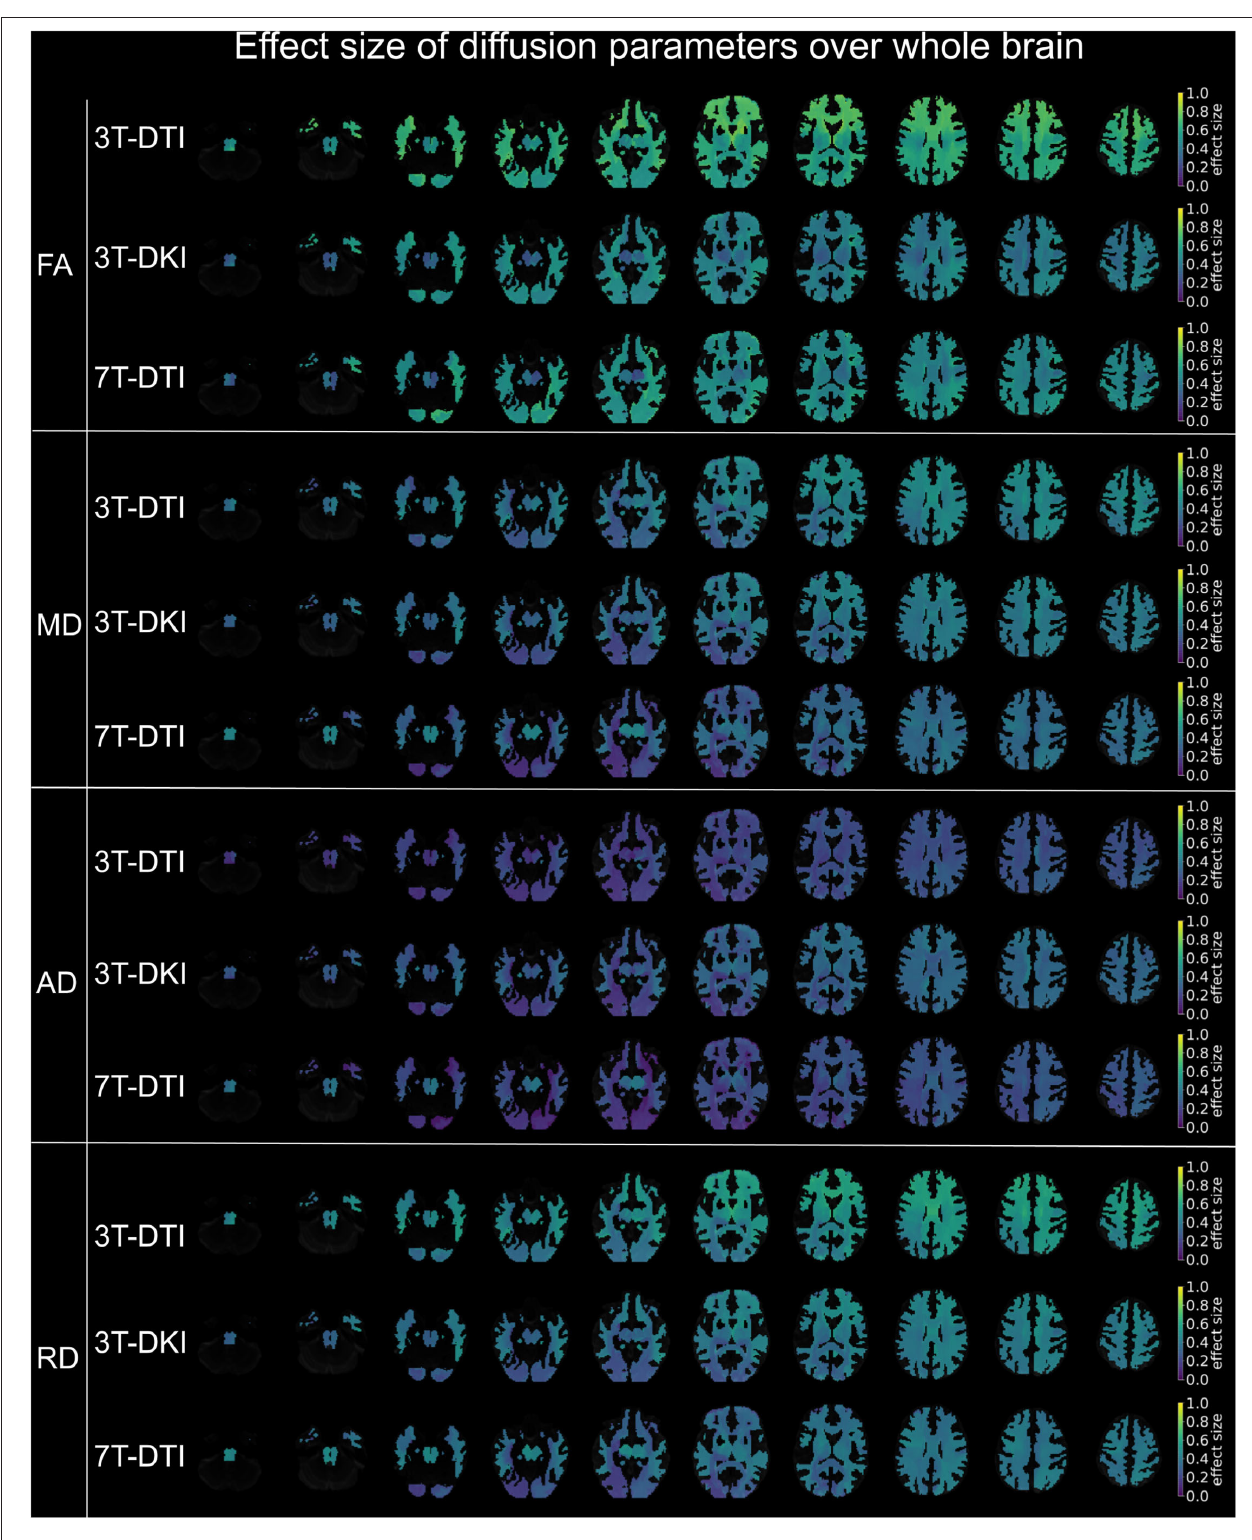
FIGURE 9 | Effect size of diffusion tensor parameters (FA, MD, AD, and RD) over the whole brain, when derived by the different acquisition protocols (3T-DTI, 3T-DKI, and 7T-DTI). Effect sizes in the depicted brains range from 0.0 (deep purple areas) to 1.0 (yellow areas). Overall, FA and RD were the parameters with the highest effect sizes across all three acquisition protocols, but the FA derived by 3T-DTI was the diffusion indices with the highest number of areas in the brain exceeding the value 0.54 of effect size. In the case of FA, 3T-DTI (top panel, first row) yielded the highest number of tracts with significantly large effect size than 3T-DKI (top panel, second row) and 7T-DTI (top panel, third row) since the brains in the top panel appear brighter than the brains in the second and third panels.